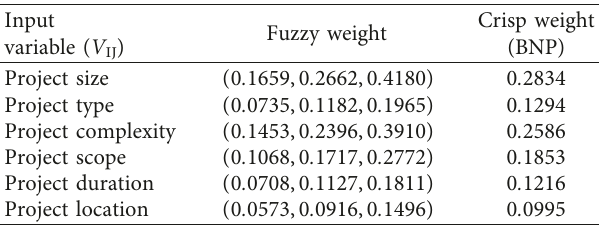
Table 5: The weight of input variables with respect to the variable group ( V 2 ). Input variable ( V IJ ) Fuzzy weight